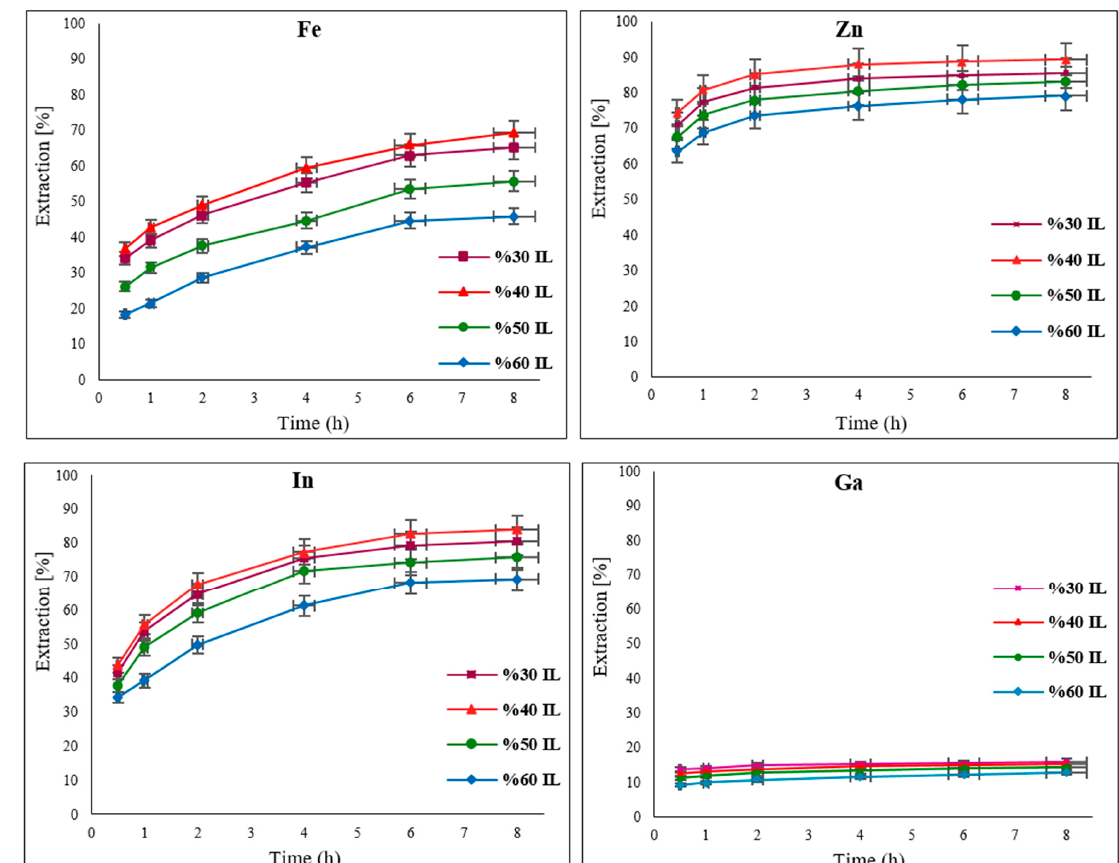
Figure 5. Effect of different concentrations of [Bmim + HSO 4 − ] of 30, 40, 50, and 60% v/v on the extraction of Fe, Zn, In, and Ga from EAFD. Experimental conditions: 50 mL of ionic liquid solution with specified concentrations, oxidant Fe 2 (SO 4 ) 3 (0.5 g), S/L ratio of 1/20, stirring speed of 500 rpm, temperature of 65 ◦ C, and total leaching time of 8